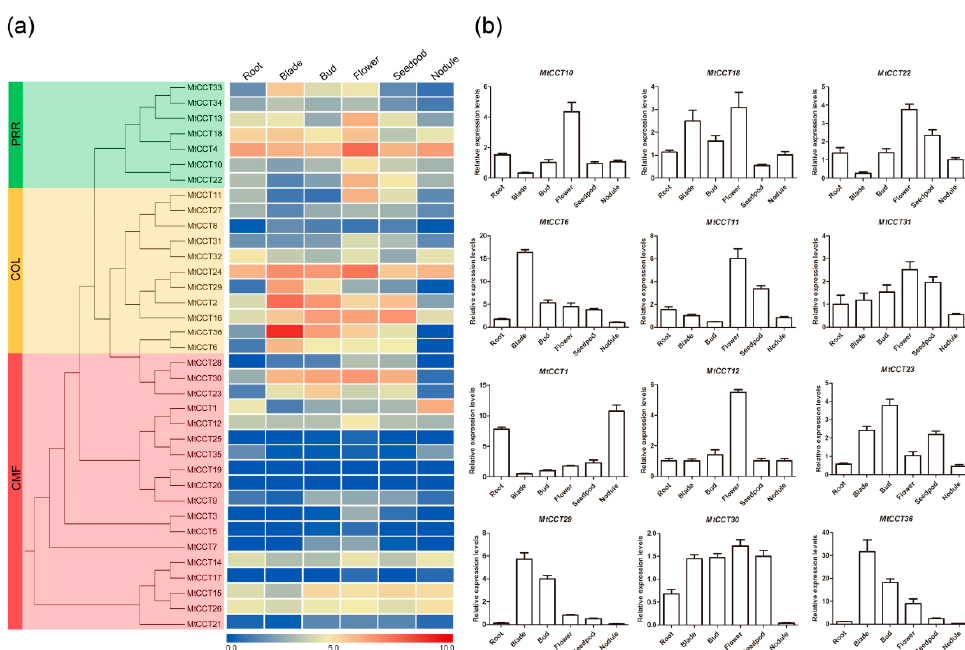
Figure 4. Expression files of MtCCT genes in six representative tissues (Root, Blade, Bud, Flower and Seedpod). ( a ) The expression heatmap of MtCCT genes constructed by electronic expression data; ( b ) The expression patterns of 12 MtCCT genes in six tissues were examined by qPCR(quantitative PCR). Expression levels are normalized to MtACTIN and error bars indicate standard deviation among three biological replicates.